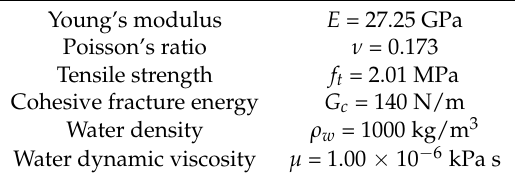
Table 2. Parameters of the concrete specimens used in the hydraulic fracture